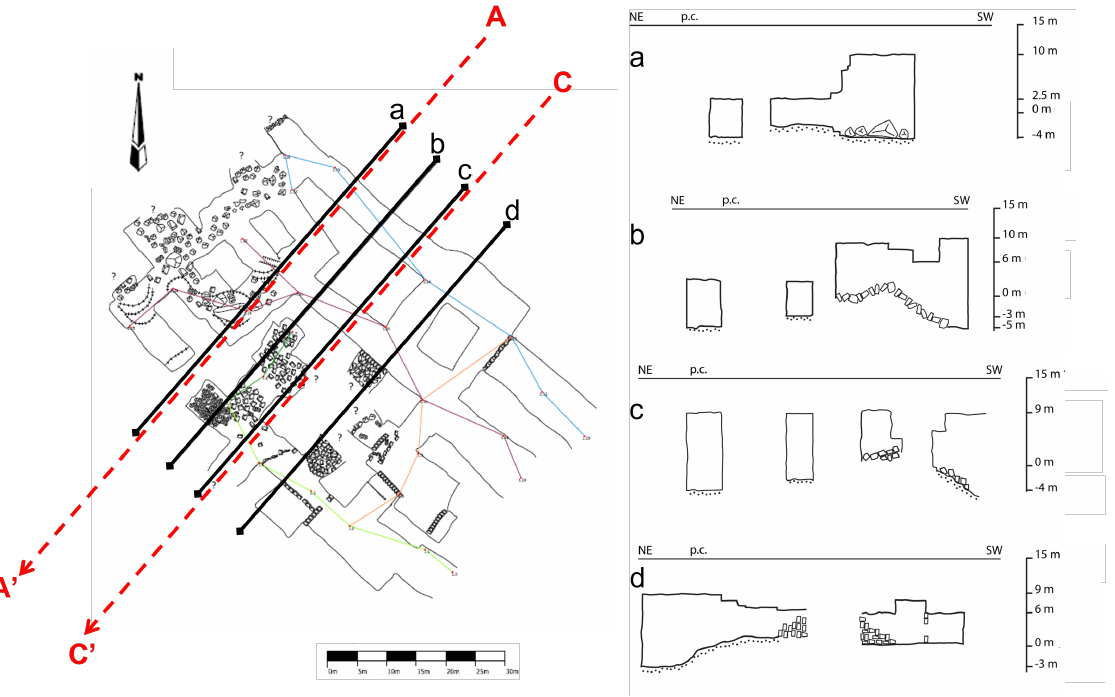
Figure 10. 3D speleological model of the Foderà Quarry: ( left ) planimetric map, where the thick black lines show the traces of the speleological sections ( right ) and the red dashed lines are the traces of the carried out electrical resistivity